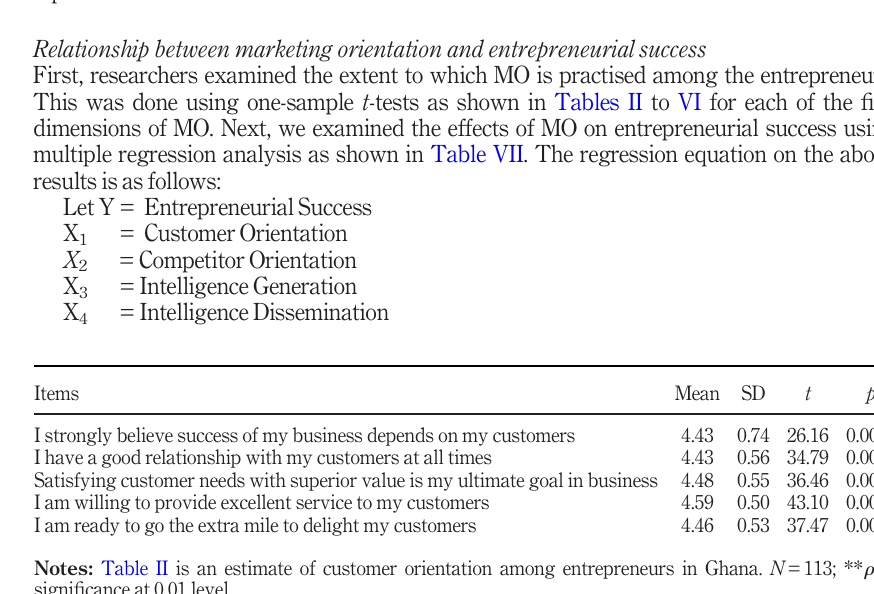
Table II. Customer